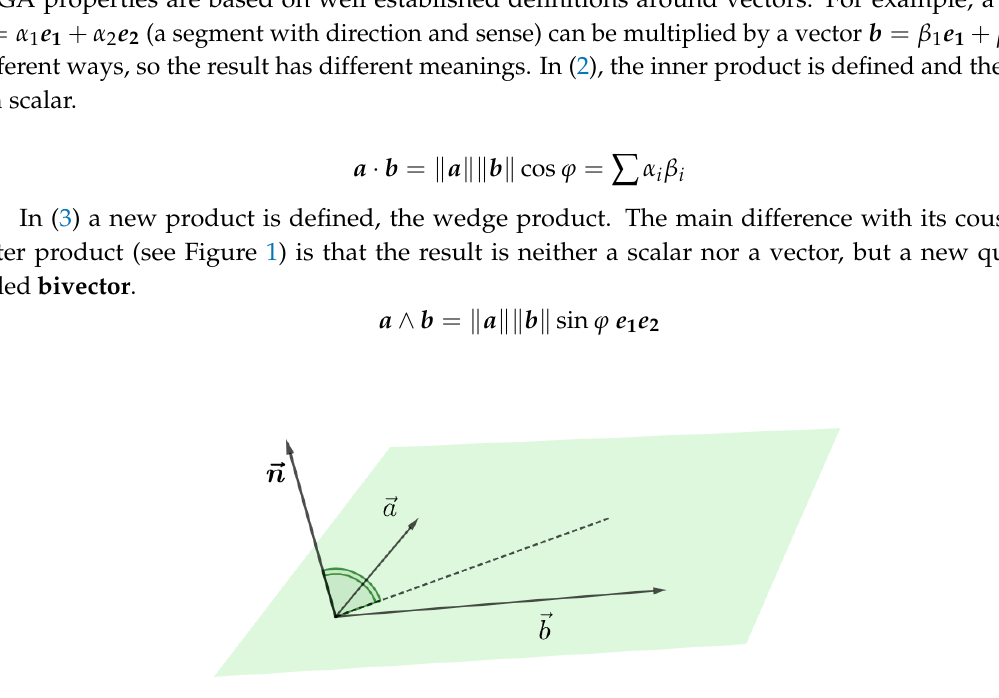
Figure 1. Outer product of vectors a and b . The result is a vector n , perpendicular to the plane formed by a and b